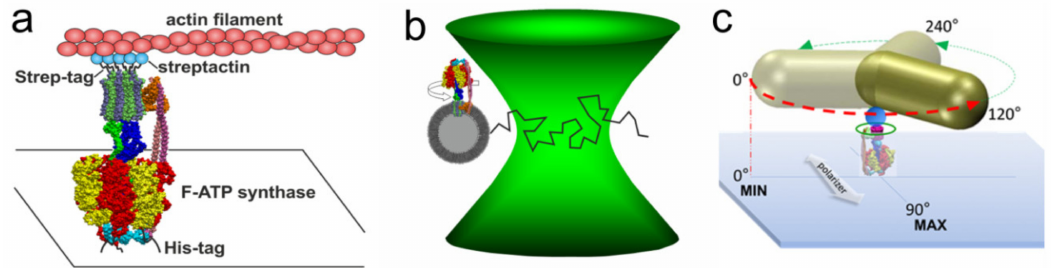
Figure 2. Single-molecule experiments with EcF O F 1 . ( a ) EcF O F 1 was attached via His-tags in each β subunit to a cover glass. A fluorescently labelled actin filament, which was attached via streptactin and Strep-tags to the c -ring, served as a reporter for rotation during ATP hydrolysis [58]. ( b ) Fluorescently labelled EcF O F 1 reconstituted in a liposome was diffusing through the confocal laser focus in a smFRET setup. Rotation of the central shaft during ATP hydrolysis was observed after addition of ATP, or ATP synthesis was powered by pmf [130]. ( c ) Immobilized EcF O F 1 with an attached AuNR is rotating in 120 ◦ steps at saturating ATP concentrations, and intensities of the scattered light from the nanorod that were observed through a polarizer progressed sinusoidal and reached a maximum after 90 ◦ rotation